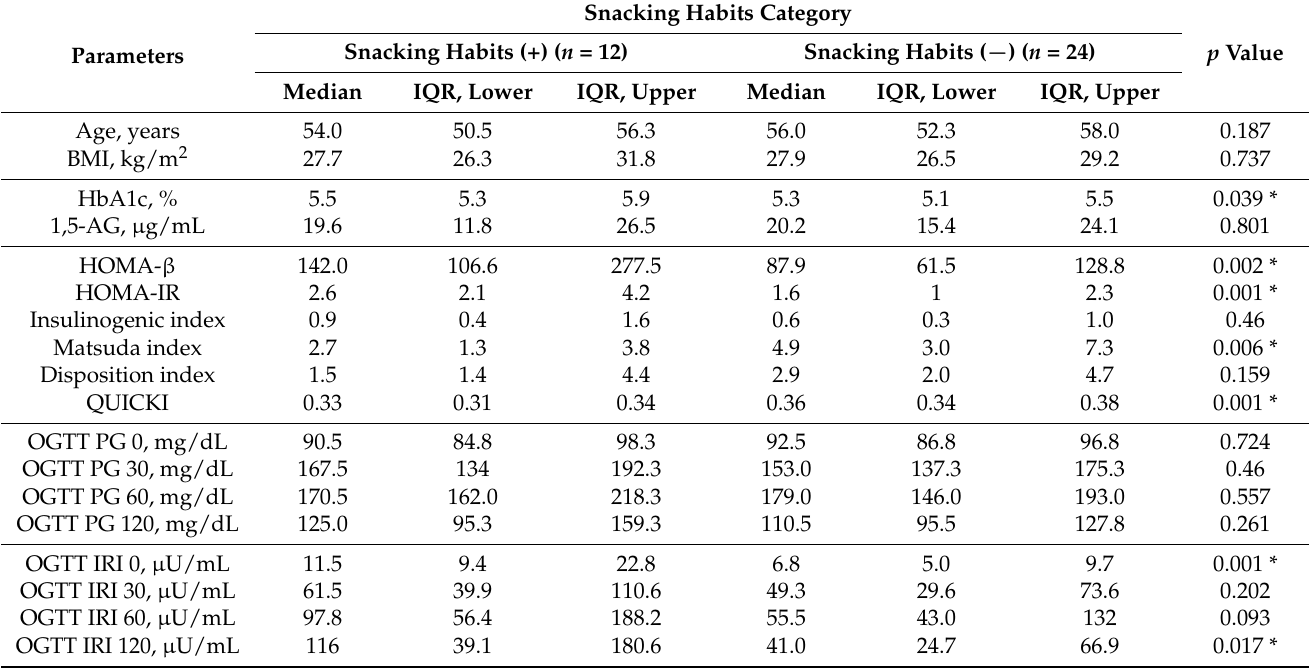
Table 5. Characteristics of the study participants according to the snacking habits